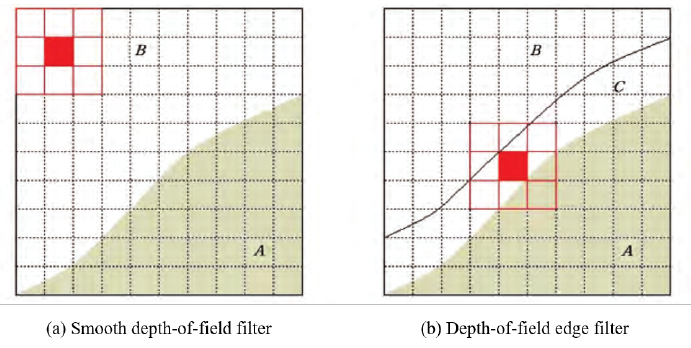
Figure 1. The figure of local filtering for flat depth-of-field areas and depth-of-field changing edges. As shown in Figure 1a (left side), when the filtering window ω ( x ) is a scene with a smooth depth of field (the filtering window is the highlighted area of close scene B in